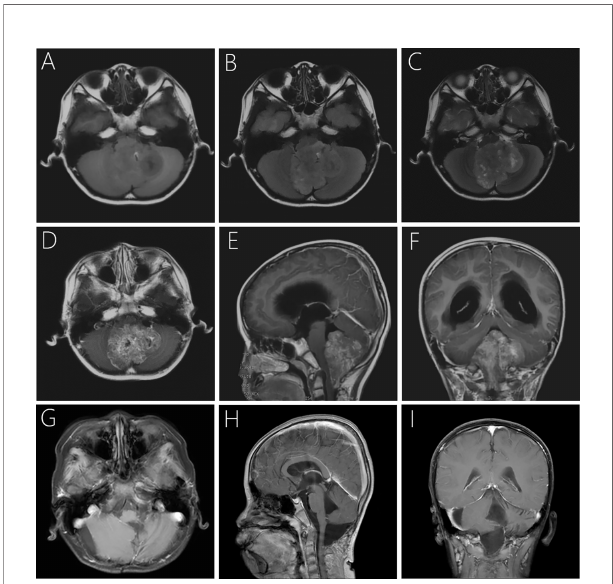
FIGURE 1 | Pre- and postoperative imaging of the child. Preoperative MRI showed hypo- and isointensity mixed signal, together with focal hyperintensity on T1WI (A) and T2-weighted FlAIR (B) . The lesion is iso- and hyperintensity mixing signals and well-circumscribed on axial T2WI (C) . Post-contrast T1WI showed moderate heterogeneous contrast enhancement of the lesion (D – F) . Follow-up MRI at 29-month after surgery revealed that the lesion was completely removed with no signs of recurrence (G – I)